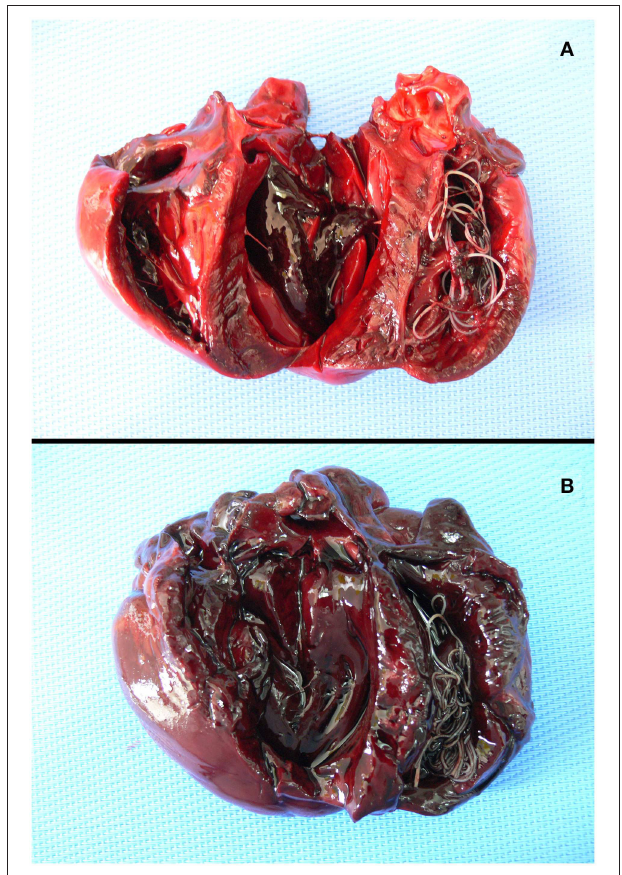
FIGURE 1 | Adult Dirofilaria immitis in the heart of male (A) and female (B) roaming dogs from the urban area of Castel